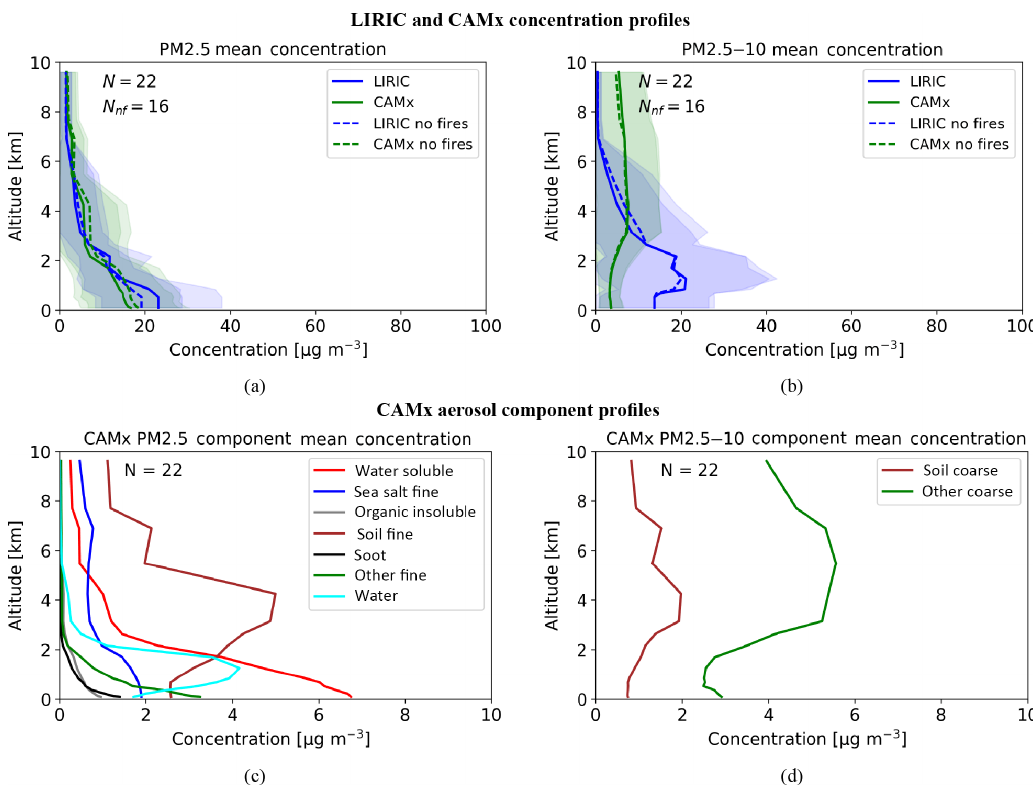
Figure 4. (a, b) Comparison of the mean PM 2 . 5 (a) and PM 2 . 5 − 10 (b) aerosol concentration profiles between LIRIC and CAMx in the period 2013–2015. The shaded regions correspond to 1 σ of each average profile. (c, d) Presentation of the mean concentration profiles per aerosol component of which the model’s PM 2 . 5 (c) and PM 2 . 5 − 10 (d) modes consist (see Table 1).